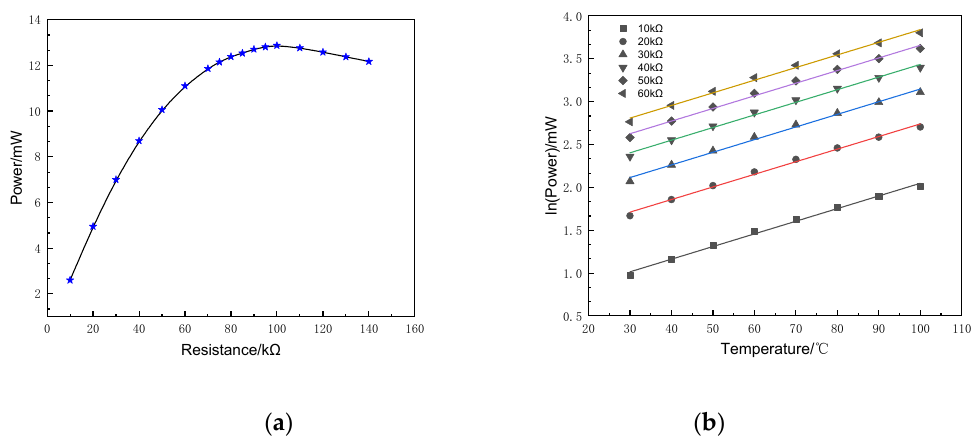
◦ C; ( b ) At temperature gradient.